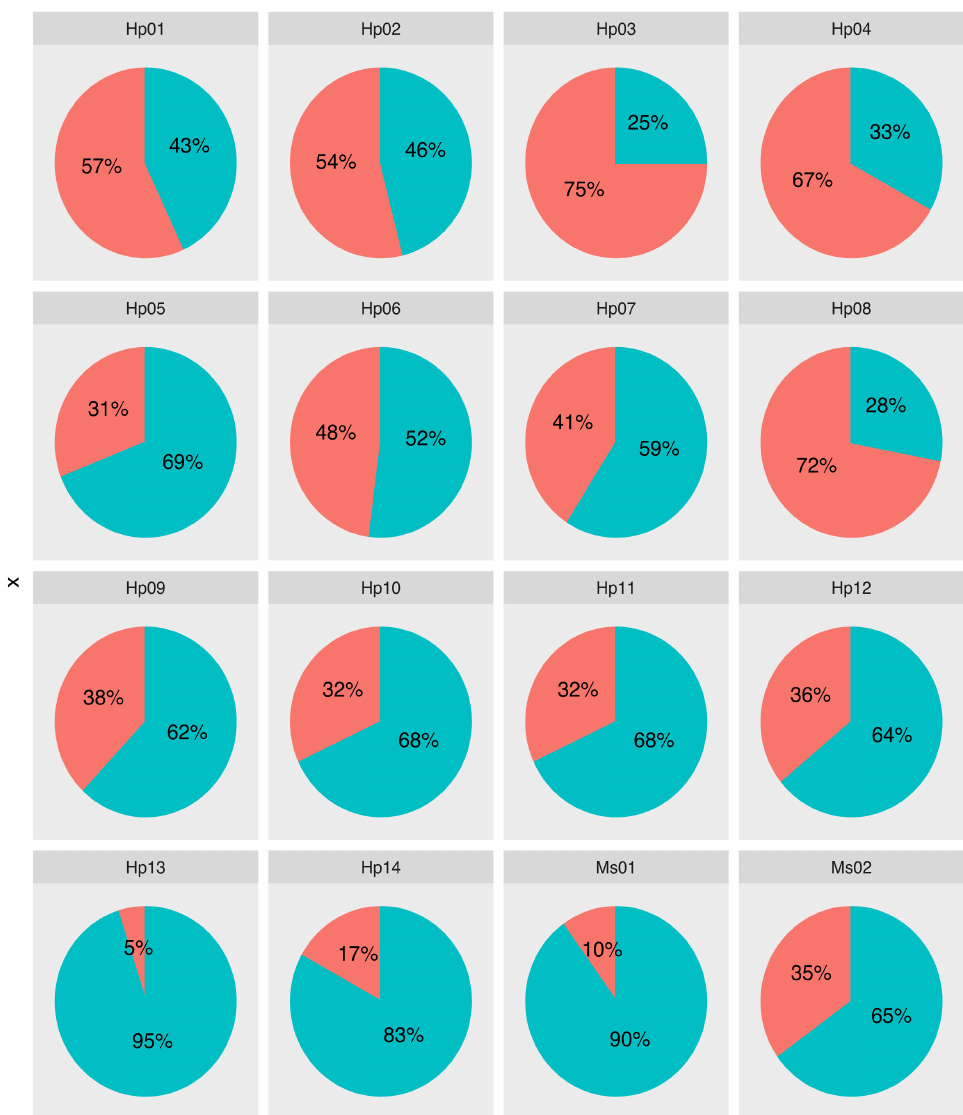
Figure 1. Proportion of reads classified (red) and unclassified (blue) at the family level. Hp: Hypera postica samples; Ms: Medicago sativa